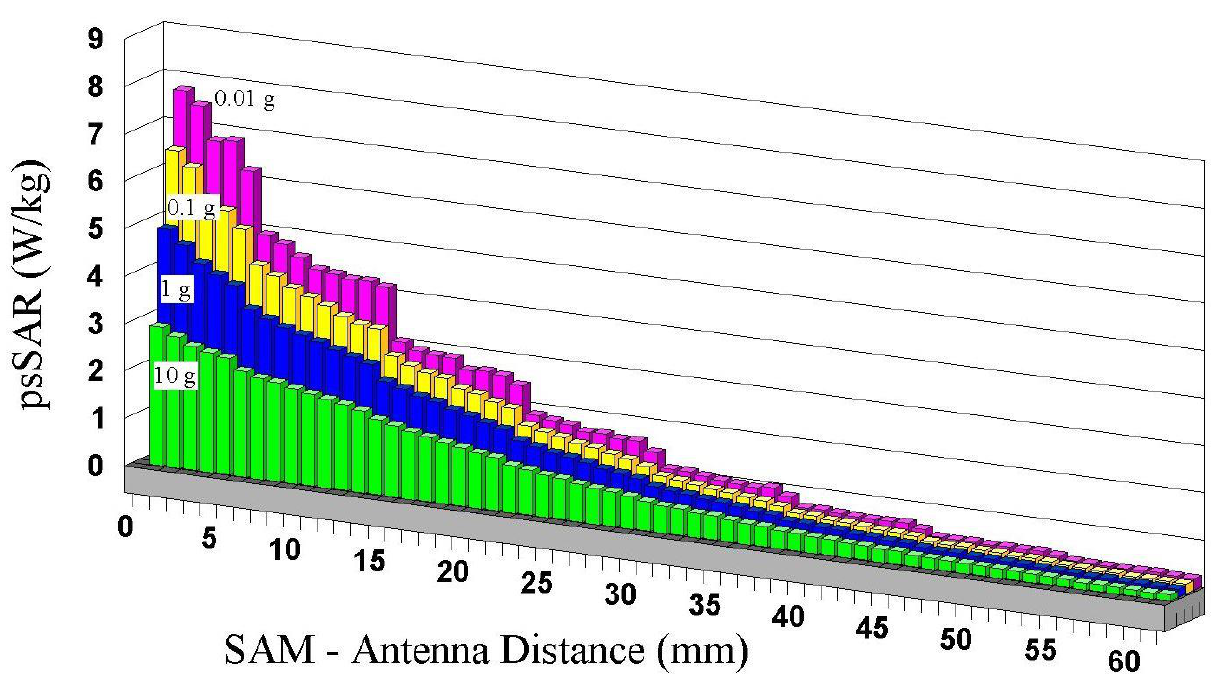
Figure 6. Peak Spatial Specific Absorption Rates (psSAR, W/kg) as a function of distance for four averaging masses. Frequency is 900 MHz and power 250 mW. Tissue and shell parameters, the shape of the Simulated Anthropomorphic Model (SAM) model (IEEE 1528), and voxels from a meshing tool with at least 10 voxels per wavelength are provided by CST Studio. Planar Inverted-F Antenna from Antenna Magus. Cell phone model is an empty plastic box with an antenna 2 mm away from the top edge. The irregularities in the curves stem from a mismatch between head shape and digitized voxels. ICNIRP uses 10 g, while IEEE-FCC uses 1 g. After [65].